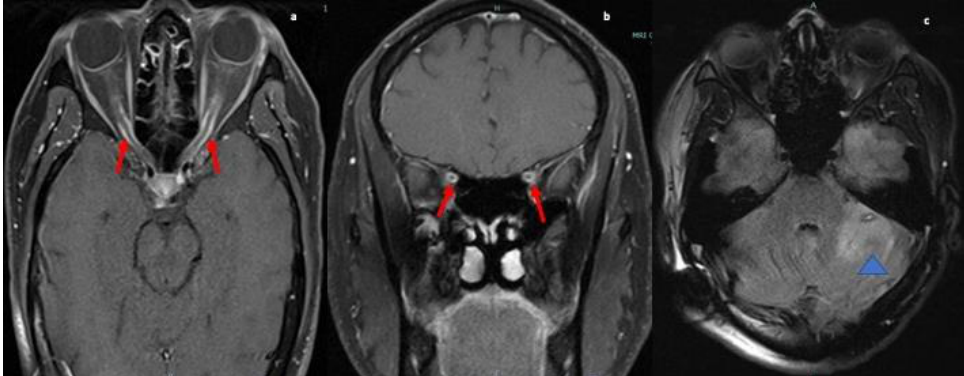
Figure 5. MRI orbit axial T1-weighted fat-suppressed post contrast image ( a ) and coronal ( b ) images reveal enhancement of bilateral optic nerve sheaths (red arrow). MRI Brain axial fluid-attenuated inversion recovery (FLAIR) ( c ) image reveals ill-defined patchy parenchymal hyperintensity in the left cerebellar hemisphere extending to the cerebellar peduncle (blue arrowhead).